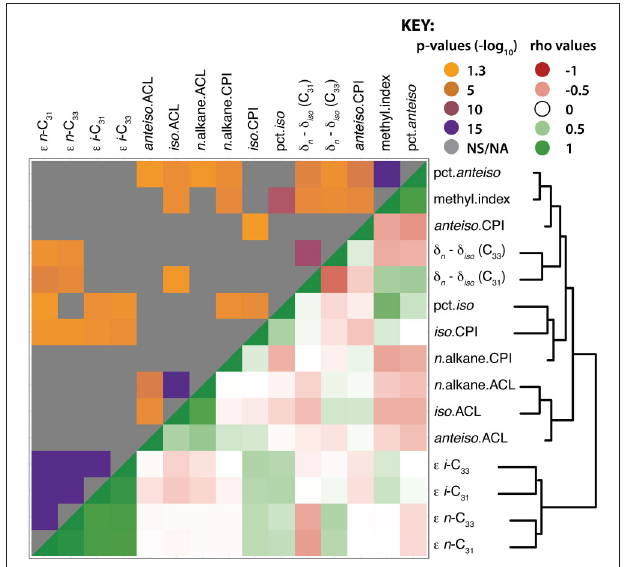
FIGURE 5 | Hierarchical clustering and correlation of leaf wax traits. Hierarchical clustering and heat map of leaf wax traits measured in this study with each other. The upper quadrant shows correlation p -values; gray indicates non-significant p -values ( p > 0.05), whereas the spectrum of orange to purple colors designate p -values ranging from less to more significant, respectively. The lower quadrant indicates Spearman’s ρ values in red (negative), white (neutral), and green (positive). The p -values and ρ values used to generate this figure are available in Supplemental Dataset 7.